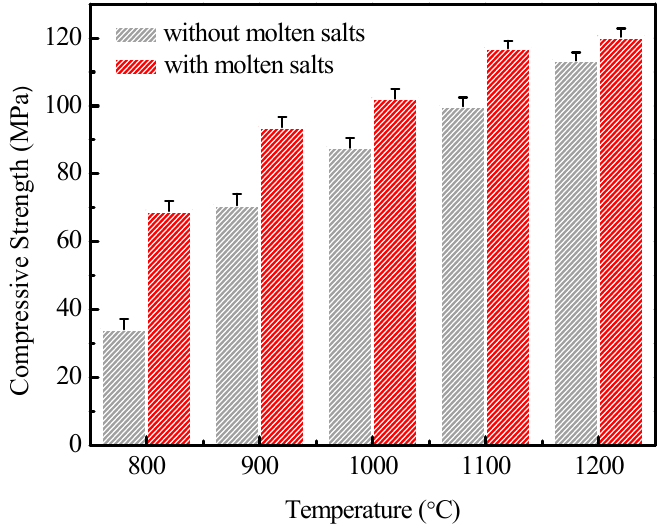
Figure 5. The compressive strengths of leucite ceramics produced under different sintering conditions.